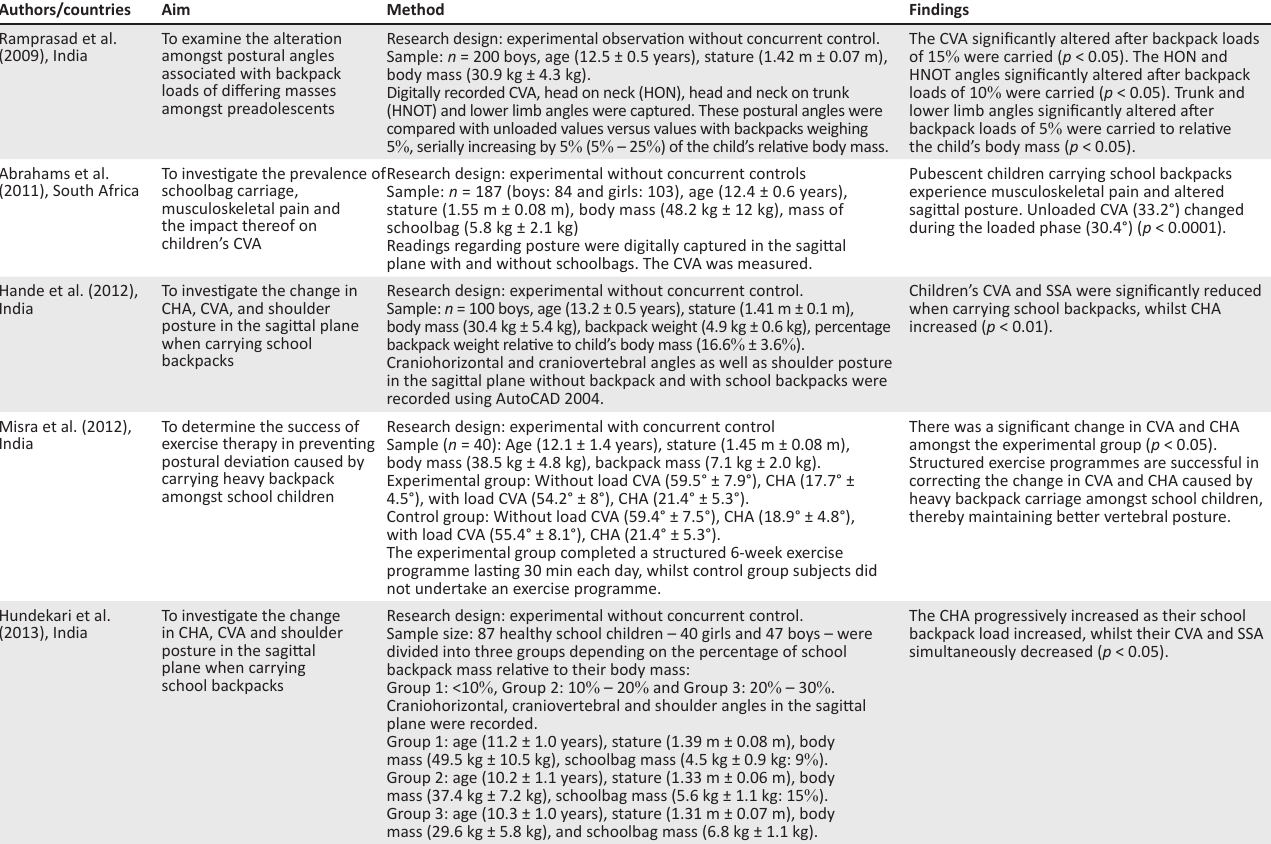
TABLE 2: Results of individual studies ( n = 14) pertaining to the influence of school backpack carriage on children’s cervical posture (2009–2019).